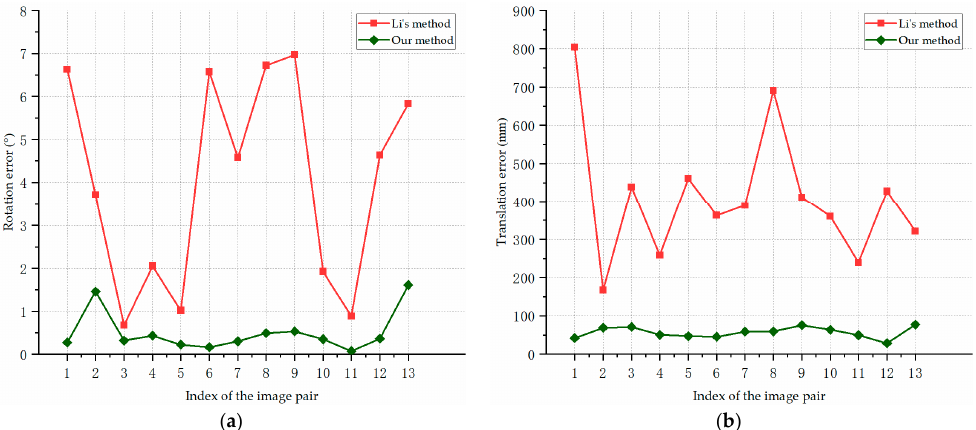
( c ) Figure 12. Wing leading edge line extraction results: ( a ) the results on an image pair of F35 model in scene 1 (Figure 11a); ( b ) the results on an image pair of F35 model in scene 2 (Figure 11b); ( c ) the results on an image pair of Cessna model in scene 2 (Figure 11c). As it was difficult for Li’s method to perform effective and reliable feature matching in these wide-baseline image pairs, the structure extraction results of our method were used to facilitate determining outliers and establishing effective feature point correspondences for Li’s method. The aircraft models were also used in Li’s method to solve the absolute pose for the comparison, while our algorithm estimates the aircraft pose with no need of these 3D models.